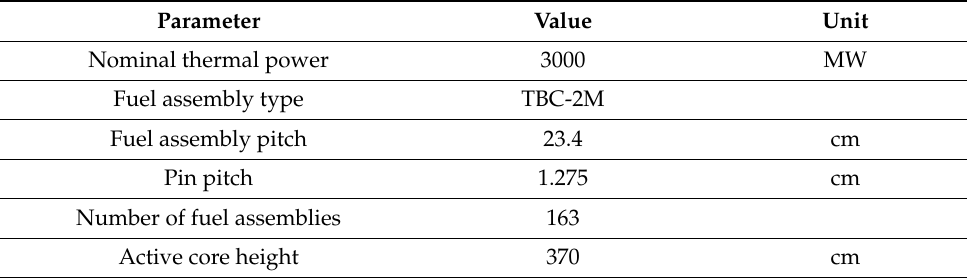
Figure 2. Radial layouts of five different Rostov-II fuel assemblies. Table 1. Specification of Rostov-II.